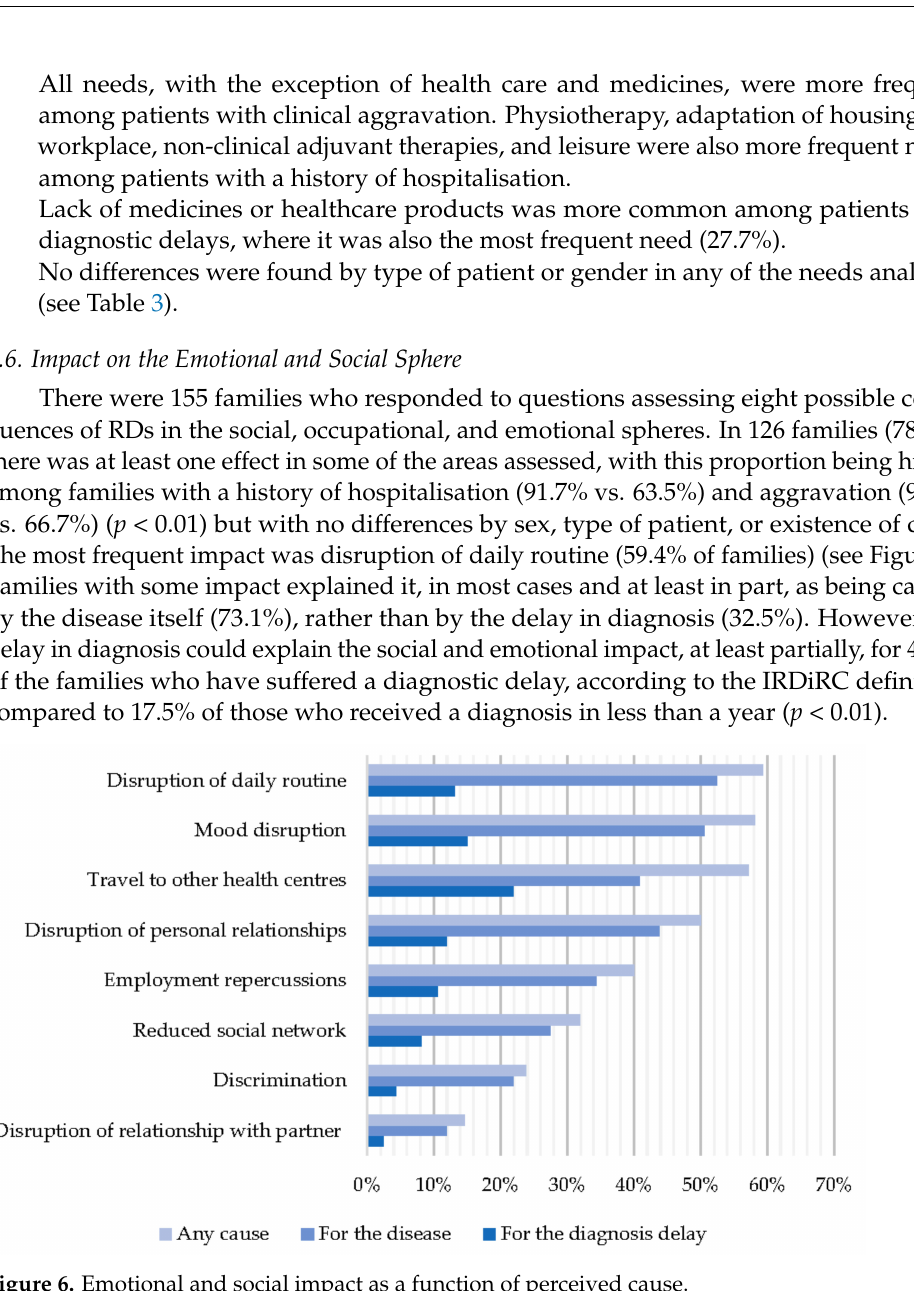
Figure 6. Emotional and social impact as a function of perceived